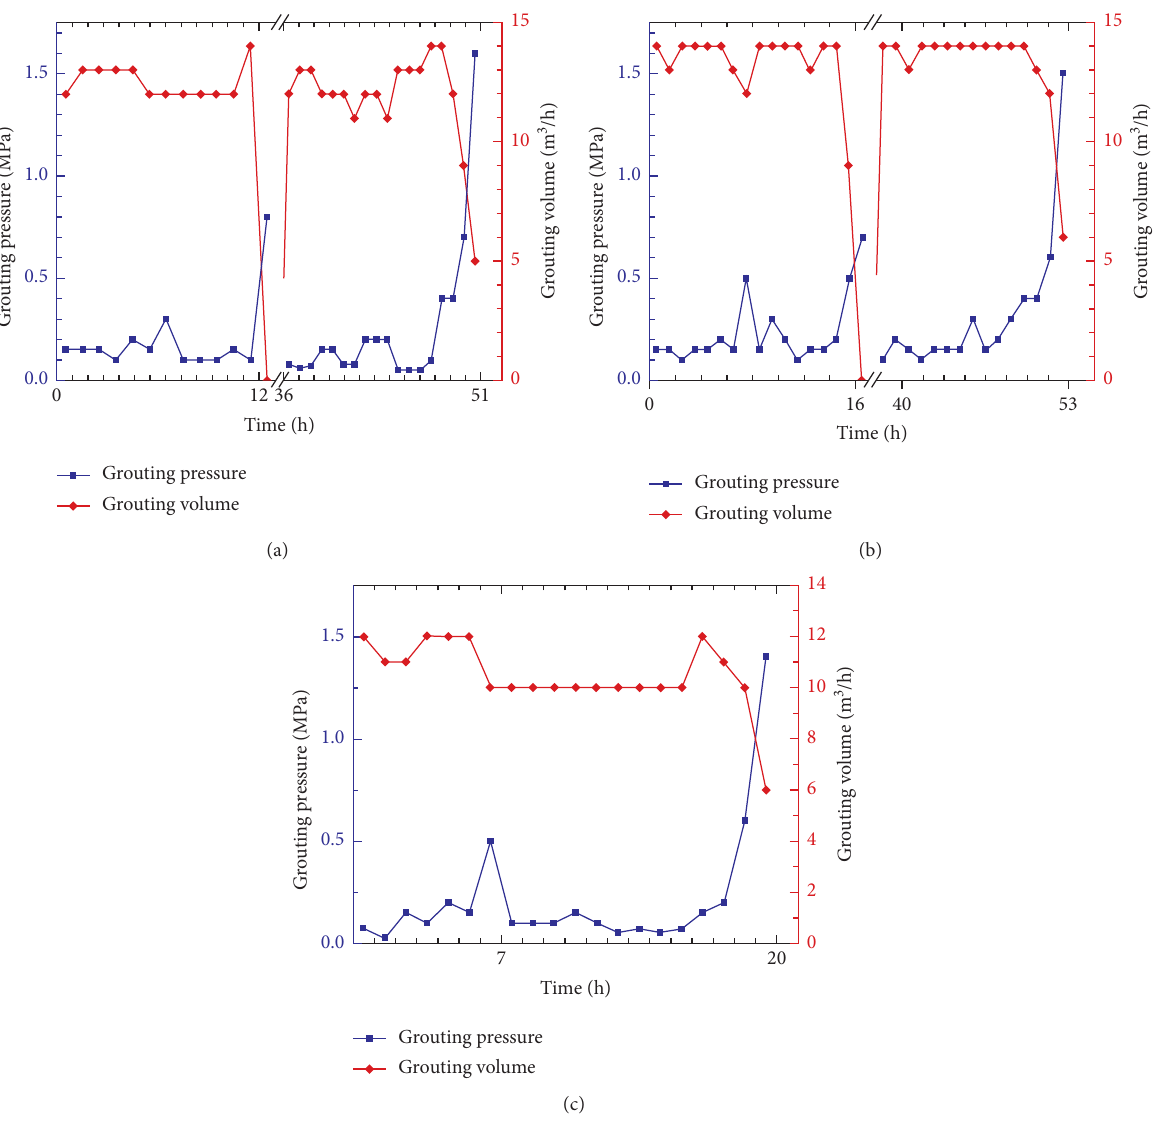
Figure 17: (a) Grouting volume and grouting pressure of W31-1 hole. (b) Grouting volume and grouting pressure of Z10-2 hole. (c) Grouting volume and grouting pressure of G2-1